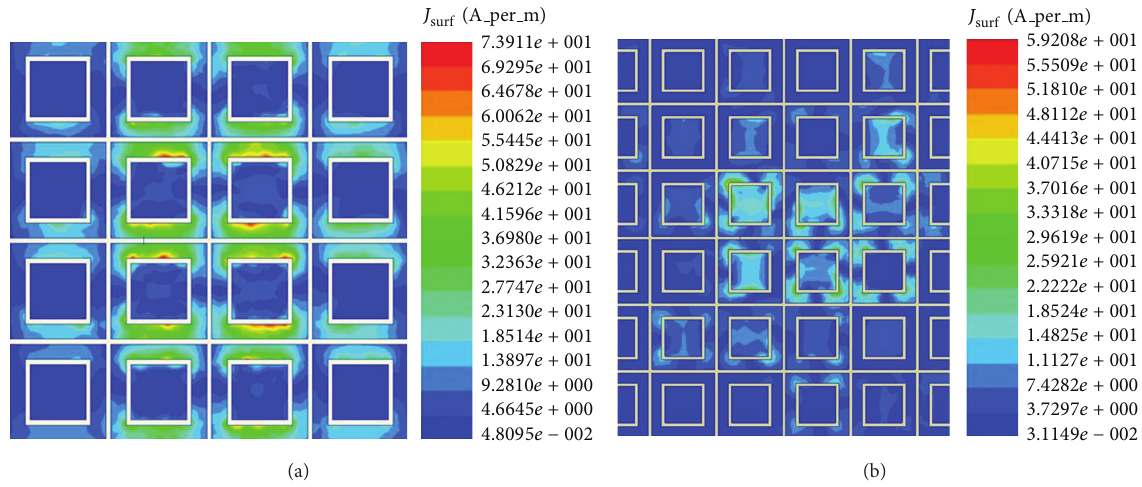
Figure 11: Surface current distribution of the AMC reflector with different dimension (a) 80 mm × 80 mm, (b) 100mm ×